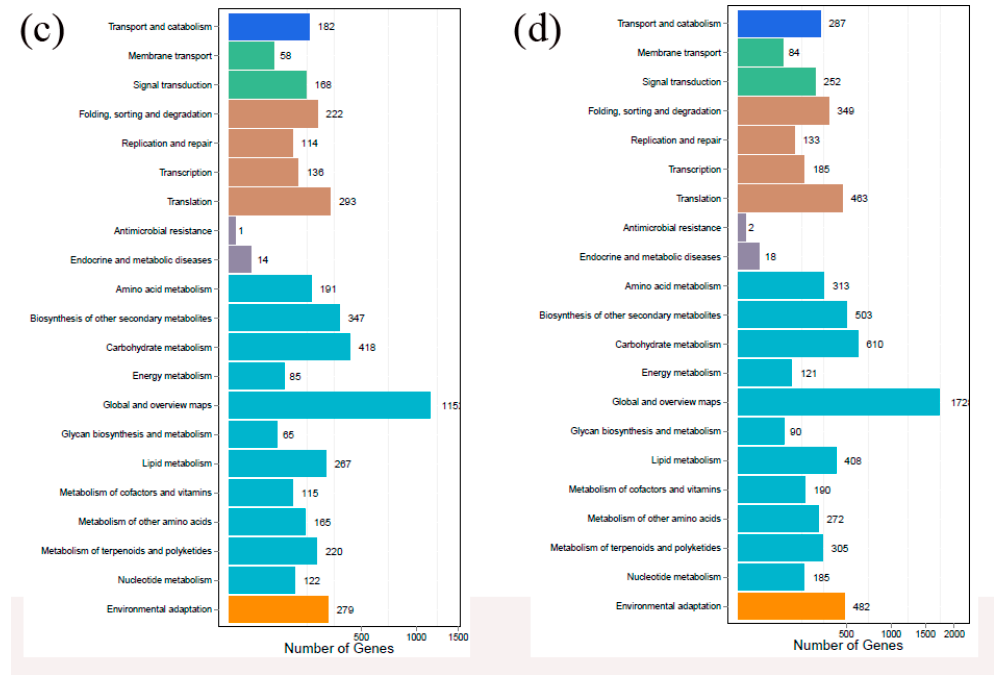
Figure 5. KEGG analysis of DEGs. ( a ) KEGG analysis of DEGs at stage A; ( b ) KEGG analysis of DEGs at stage B; ( c ) KEGG analysis of DEGs at stage C; ( d ) KEGG analysis of DEGs at stage D.